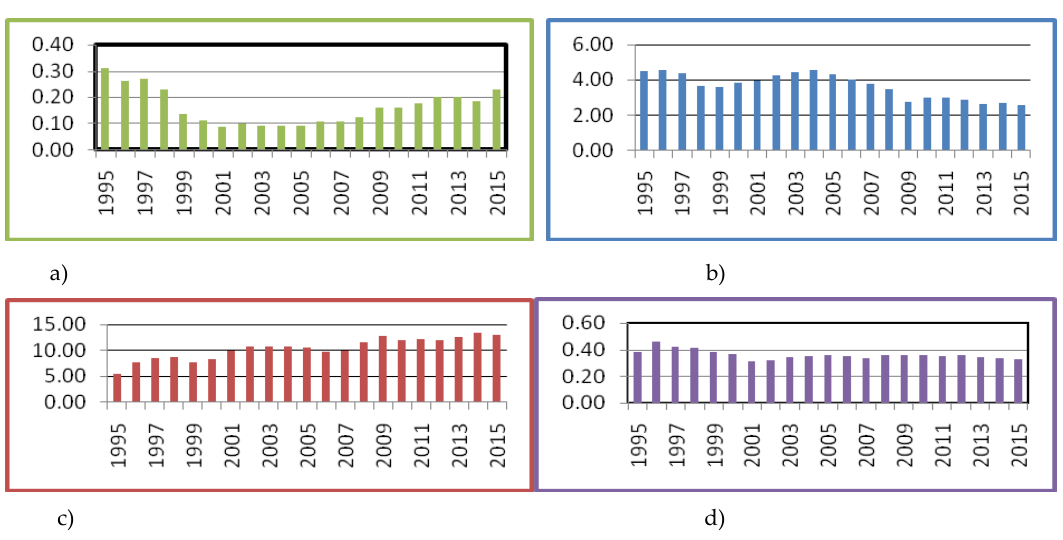
Figure 7. Evolution of energy efficiency, 1995-2015: ( a ) in agriculture; ( b ) in industry and construction; ( c ) in transport; ( d ) in